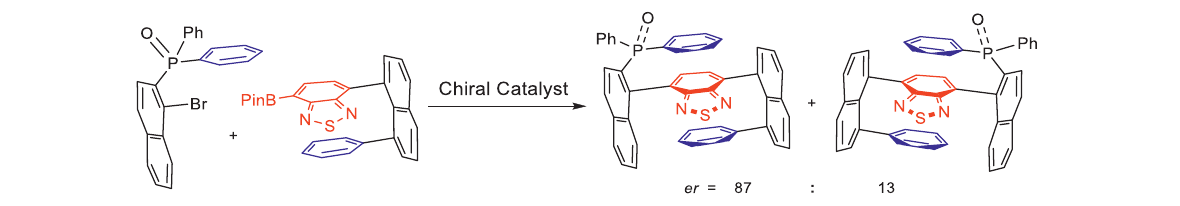
Frontiers in Chemistry |